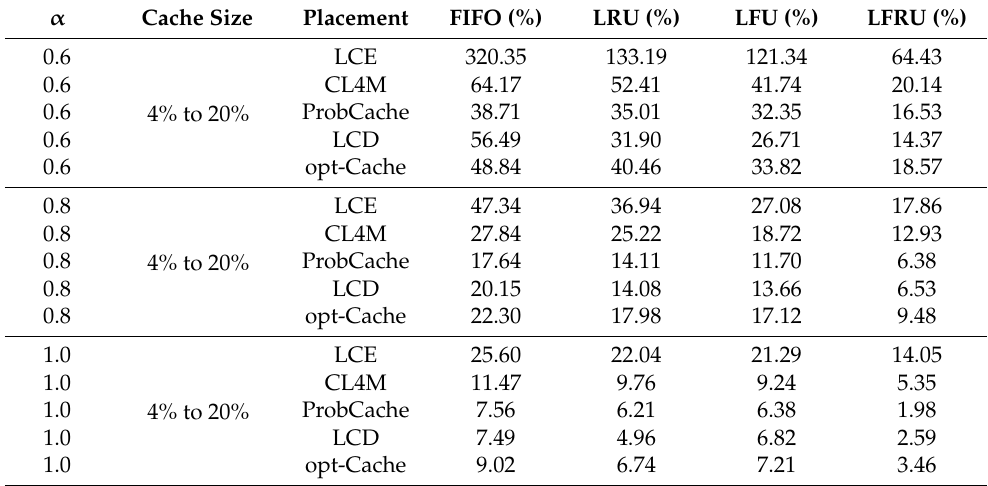
Table 10. IMU cache hit ratio percentage